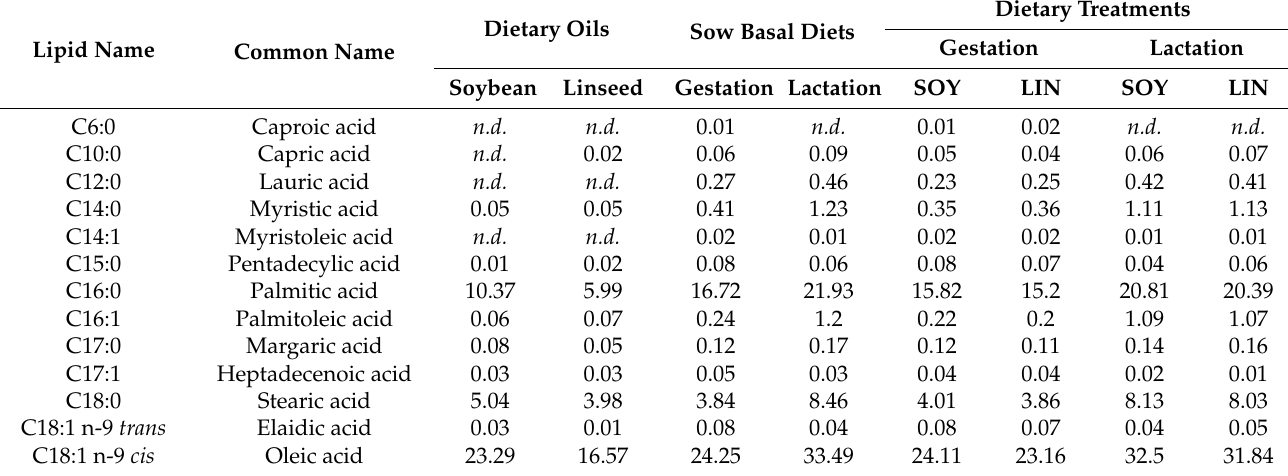
Table 6. Fatty acids * (g/100 g total fatty acids) of dietary oils and sow